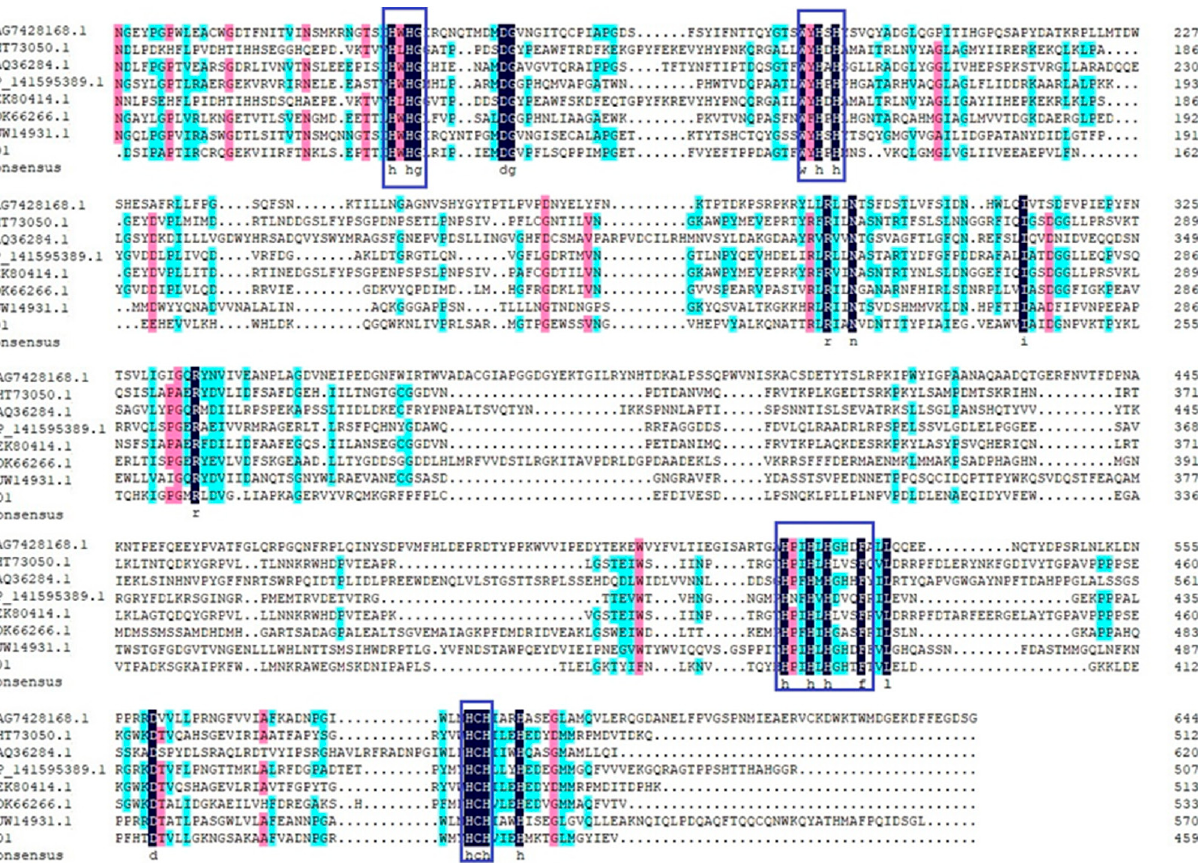
Figure 2. Multiple sequence alignments of L01 with other well-characterized bacterial and fungal laccases, with conserved motifs marked in blue boxes.